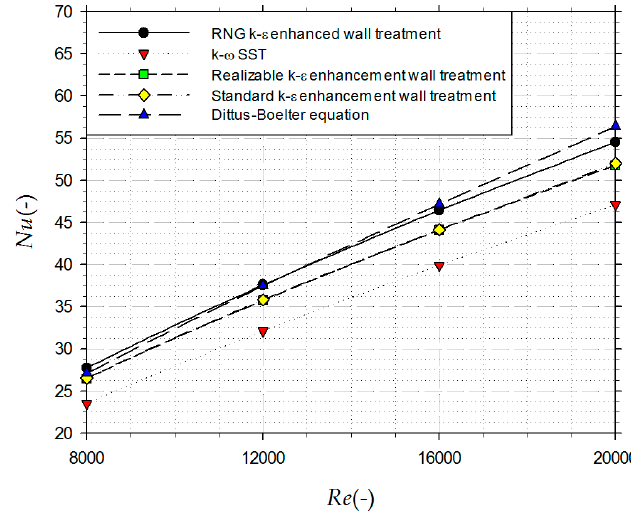
Figure 3. Comparison of Nusselt number predicted by different turbulence models with Dittus-Boelter empirical correlation for smooth duct.